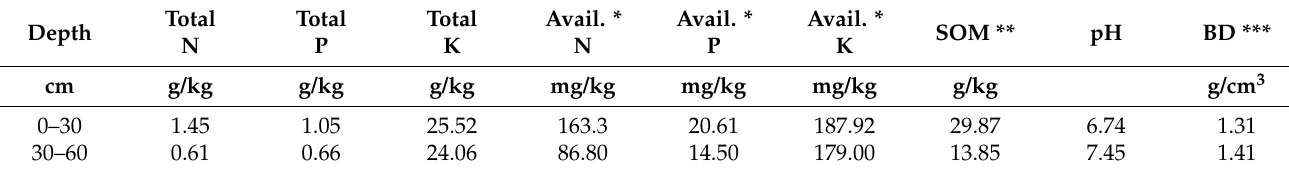
Table 1. Basic properties of the 0–60 cm soil layers.